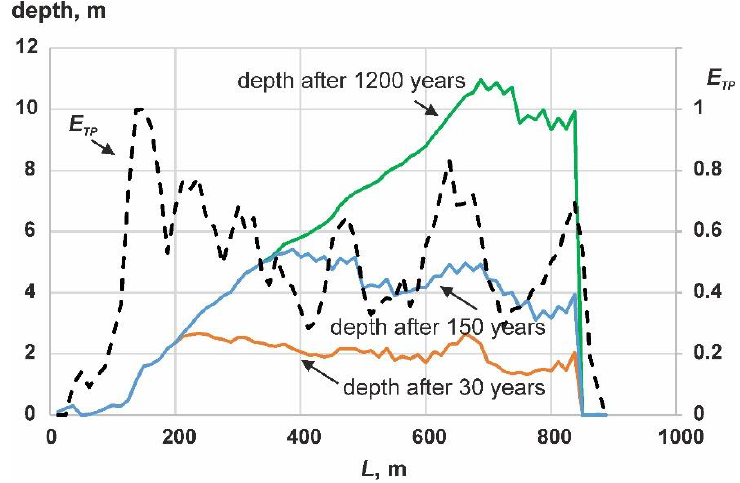
Figure 6. The gully P-1 incision depths for 30-, 150- and 1200-years calculation periods with GULTEM. Black dashed line shows total erosion potential, calculated with the TEP model.